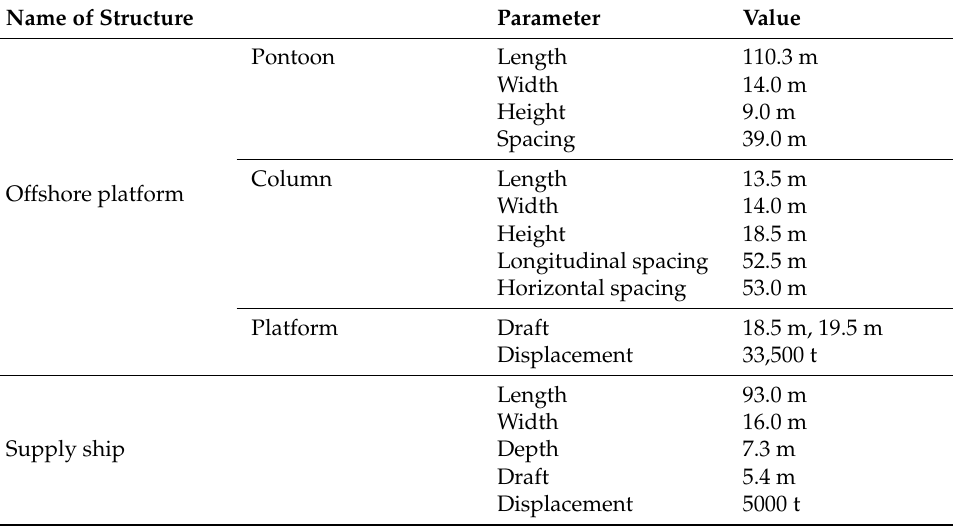
Table 3. The main structural parameters of the support platform and the supply ship. Name of